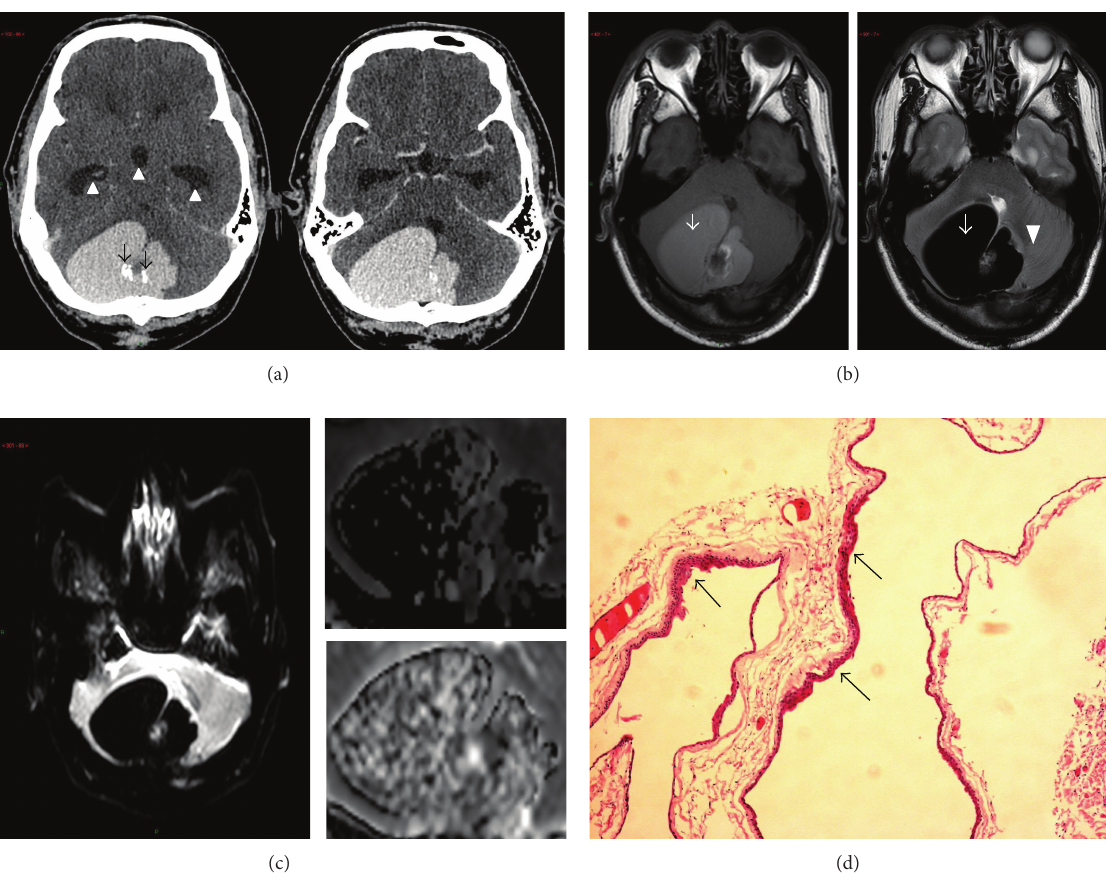
Figure 1: (a) Plain CT brain shows a lobulated, uniform hyperdense cystic lesion in right cerebellar hemisphere with coarse calcifications (black arrows) and no appreciable contrast enhancement (not shown). Note the acute angle the lesion makes with the calvarium and lobulated contour suggestive of its intraparenchymal location. Hydrocephalus involves the third ventricle and temporal horns of both lateral ventricles (white arrowheads) are due to the mass effect on the fourth ventricle. Histology confirmed the lesion as an epidermoid cyst. (b) T1-weighted (left) and T2-weighted (right) MRI images of the epidermoid cyst show mild T1 hyperintense and dramatic T2 hypointense signal (white arrows). The signal combination is completely opposite to the typical epidermoid cyst. There is no appreciable contrast enhancement after IV gadolinium (not shown). Note the lack of significant perilesional oedema in the cerebellum (arrowhead), a cardinal characteristic of an epidermoid cyst. (c) Diffusion weighted image (DWI) with 𝑏 factor 1000 (left panel), magnified masked apparent diffusion coefficient (ADC) (right upper), and unmasked ADC (right lower) images demonstrate no appreciable restricted diffusion with marked hypointensity on the DWI. While the hypointense signal in the masked ADC map may suggest restricted diffusion, this was a result of postimage processing of ignoring low intensity voxels of bones or air. Raw unmasked ADC map (right lower panel) confirms the lack of restricted diffusion, as evident by its isointense signal. (d) H&E section ( × 100 magnification) of the postsurgical specimen shows thin cyst wall (black arrows) with keratinizing squamous epithelium; features are compatible with an epidermoid